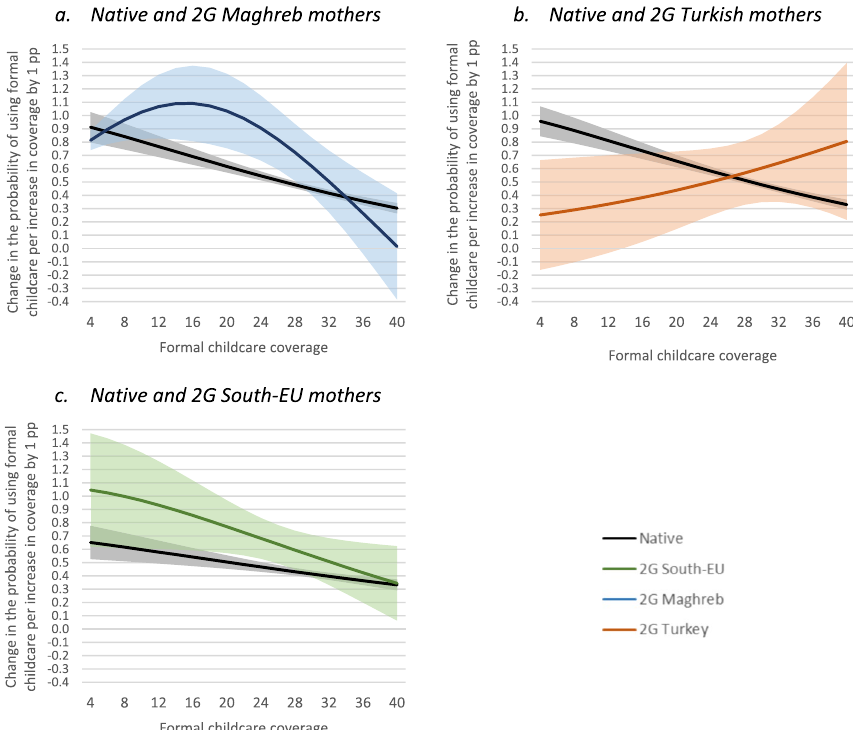
Fig. 6 Change in the probability of using formal childcare for a 1 percentage point increase in childcare coverage at different levels of childcare coverage (with 95% conf. interval), by mother’s origin group. Average Marginal Effects based on Model 3 including municipality fixed effects, coverage (quadratic specification), origin, origin * municipality and origin * coverage (quadratic specification). (Source: Belgian Census 2011 linked to longitudinal register data, longitudinal tax return data on childcare expenses and municipality-level data on childcare coverage from K&G and ONE. Calculations by